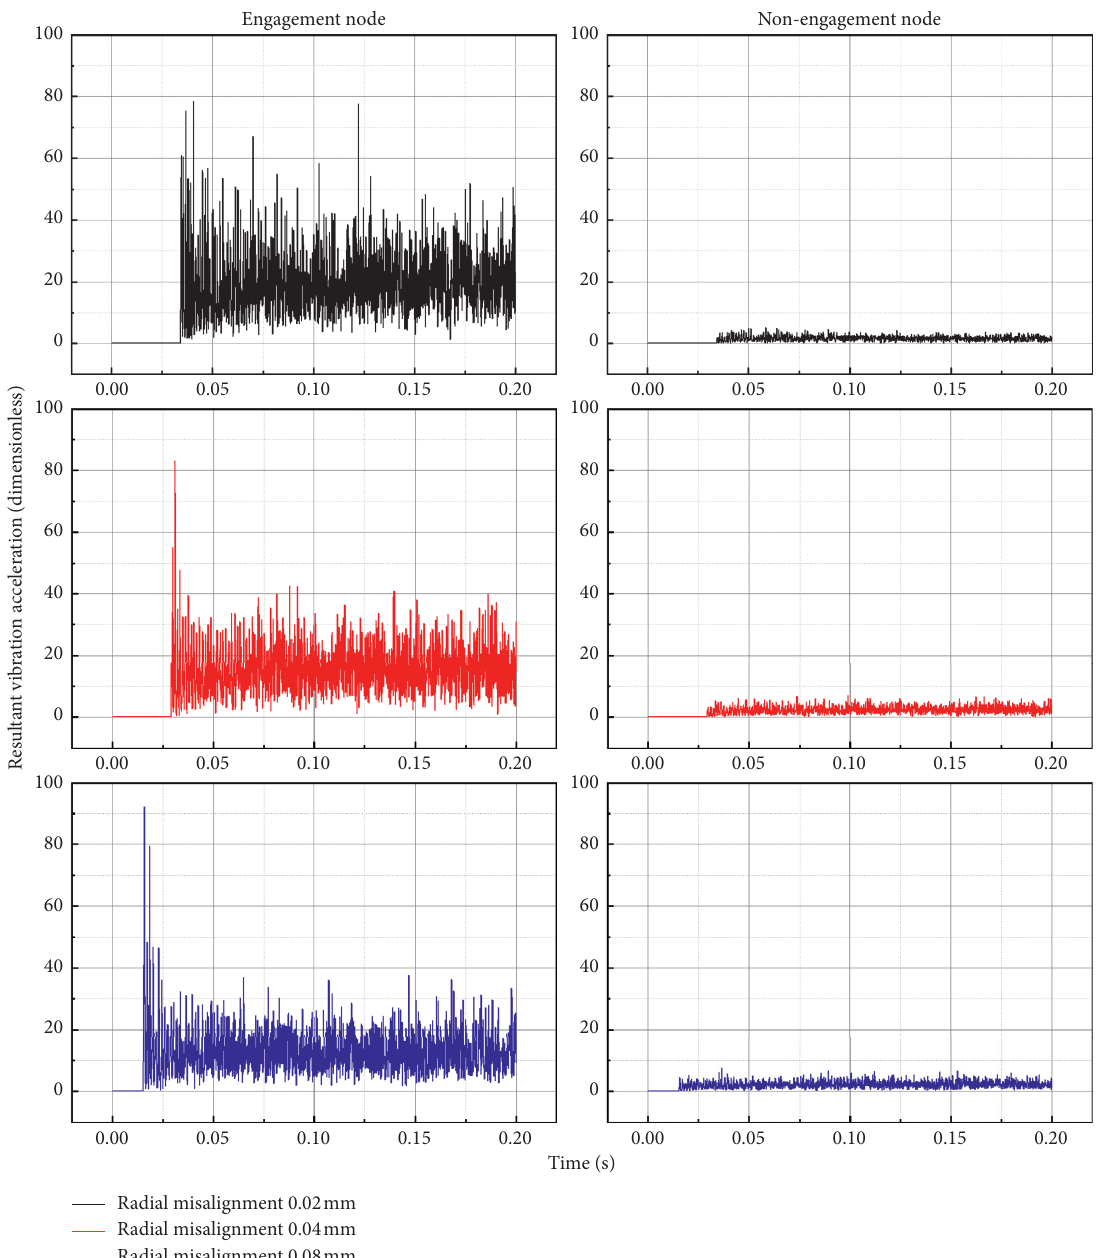
Figure 16: The comparison of resultant vibration of two categories nodes on axle spline with different radial misalignments δ under the identical loading